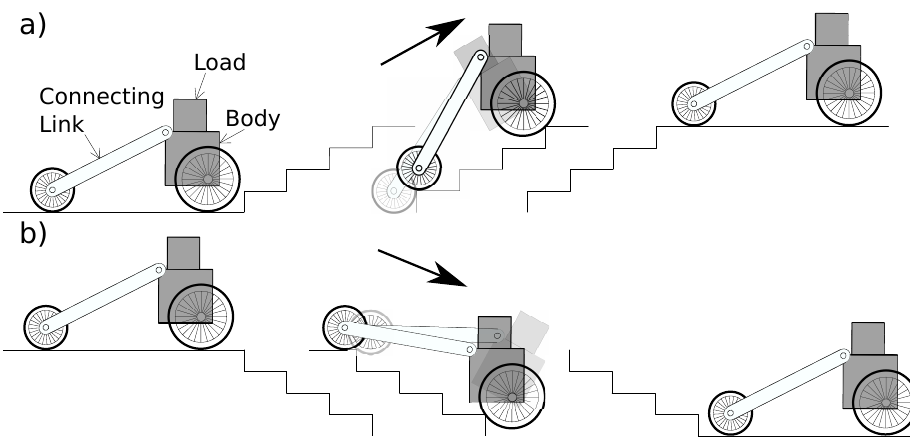
Figure 1. Schematic showing different positions of the robot (it may be noted that the front wheel diameter is larger than the step height); ( a ) ascending the stairs; ( b ) descending the